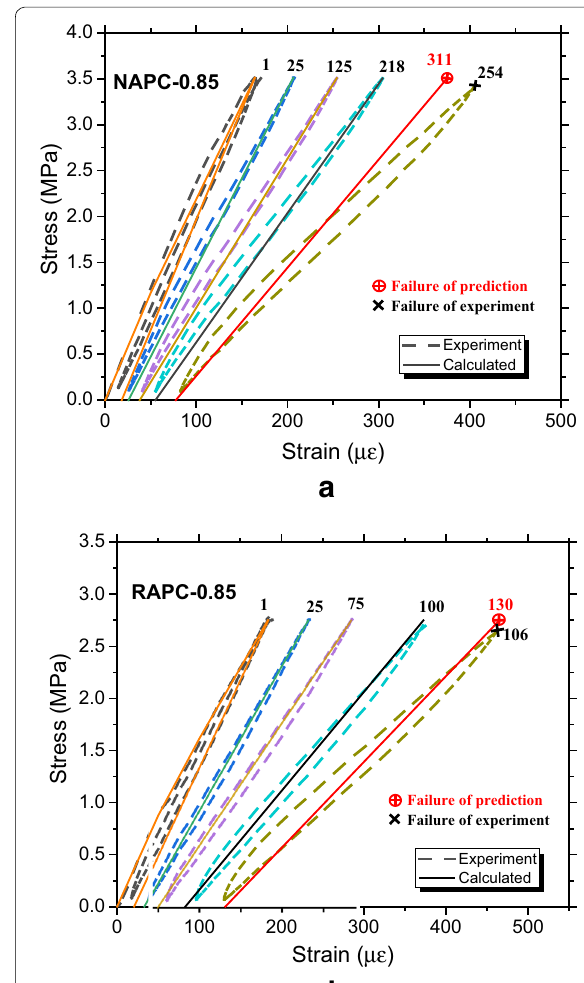
Fig. 16 Model verification under the stress level of 0.85: a NAPC and b